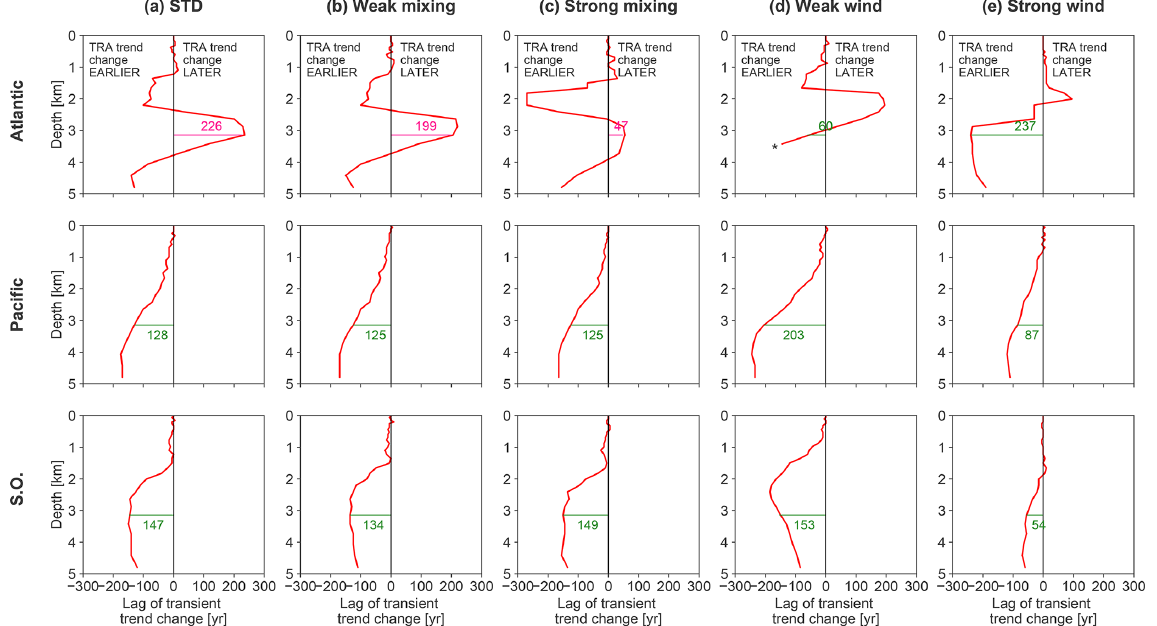
Figure 10. Lags (positive) or leads (negative) in the arrival of the warming at each depth (transient minus fixed simulation). Results are shown for (a) the standard simulations OcTRA and OcFIX (repeated from Fig. 4c), (b, c) simulations with varying mixing (OcTRA_weakmix and OcFIX_weakmix in b and OcTRA_strongmix and OcFIX_strongmix in c ) and (d, e) varying wind stress (OcTRA_weakwind and OcFIX_weakwind in d and OcTRA_strongwind and OcFIX_strongwind in e ). Numbers indicate the values of leads and lags at 3.1km depth. ∗ For (d) , the red line stops in the Atlantic below 3.4km, because the LIA cooling anomaly is not detectable in OcFIX_weakwind at these depths such that its trend change is